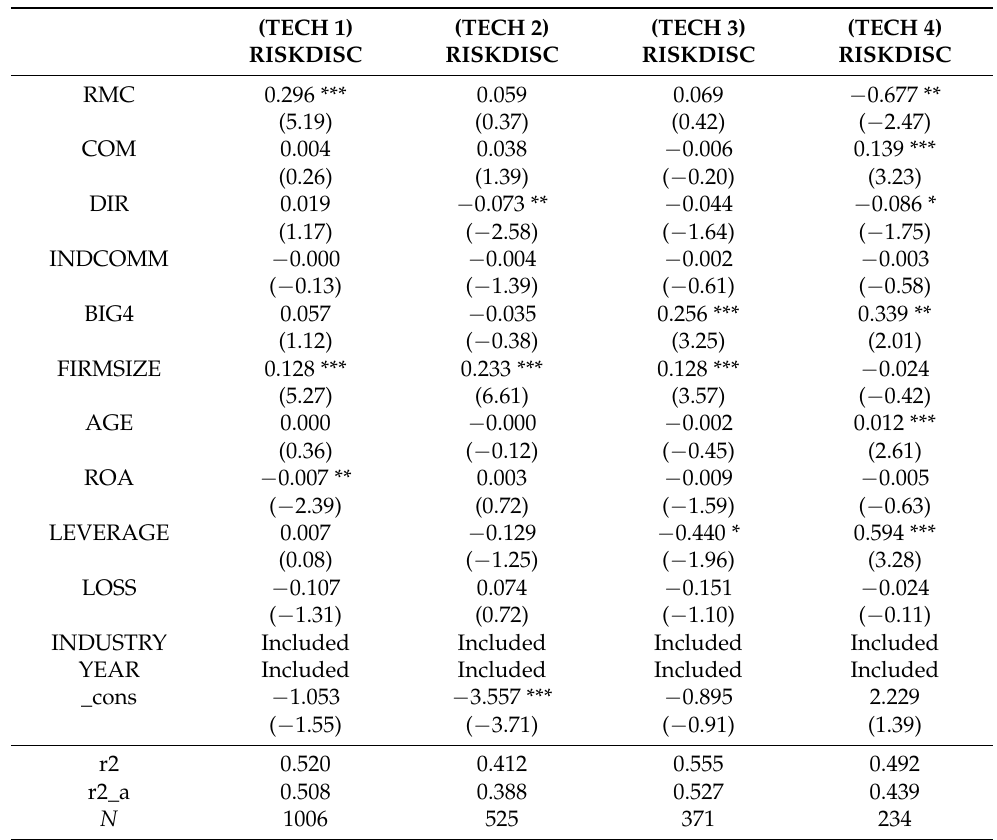
Table 7. Industry technology